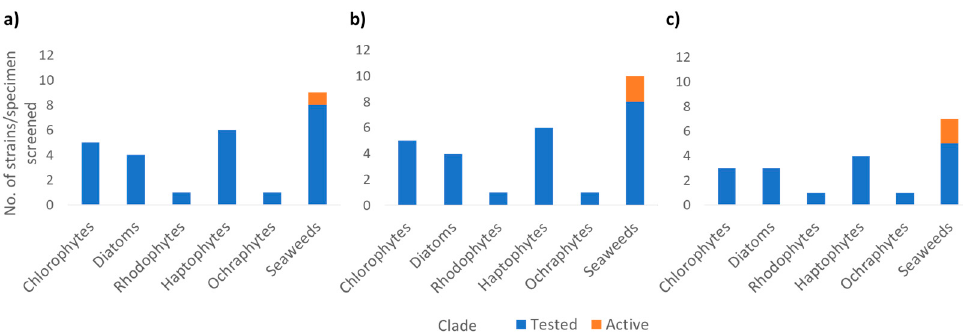
Figure 4. Bioassay screening results of extracts from each group tested (blue) and active (orange) for ( a ) endothelial lipase (EL), ( b ) proliferator-activated receptor alpha (PPAR α ), and ( c ) protein tyrosine phosphatase 1B (PTP1B). For the EL and PPAR α assays extracts were selected as “active” if they fell within the mean plus 3 standard deviations of the distribution of % activity of vehicle control wells (Figure S3. For PTP1B assay A threshold of 60% inhibition was designated as “active”.